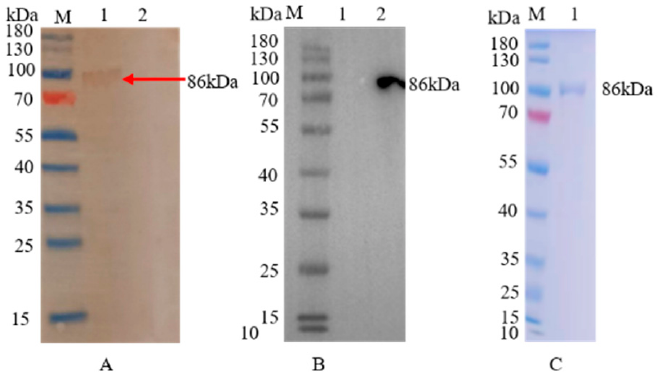
Figure 2. Expression and puri fi cation of rCap. ( A ) Western blo tt ing analysis of rBV-ORF2 with mouse anti-ORF2 polyclonal antibodies. M: Protein molecular marker; Lane 1: the Sf9 cells transfected with rBacmid-ORF2; Lane 2: the Sf9 cells transfected with rBacmid control. ( B ) Western blotting analysis of rBV-ORF2 with mouse anti-flag monoclonal antibodies. M: Protein molecular marker; Lane 1: the Sf9 cells transfected with rBacmid control; Lane 2: the Sf9 cells transfected with rBacmid-ORF2; ( C ) The SDS-PAGE analysis of purified rCap. M: Protein molecular marker; Lane 1: purified rCap.